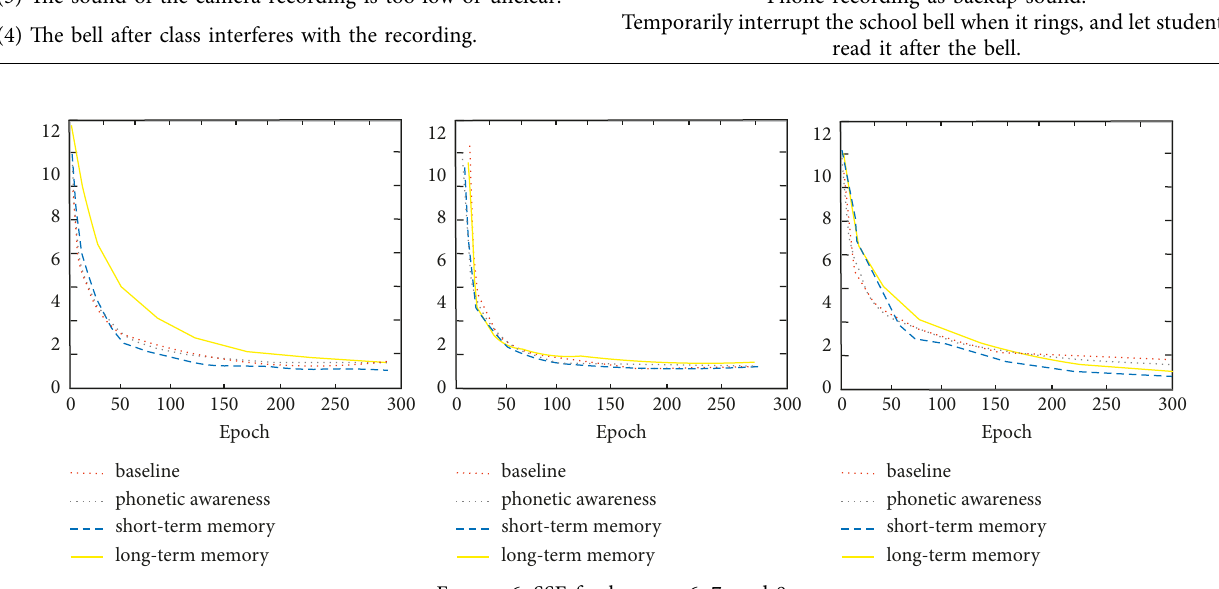
Figure 6: SSE for learners 6, 7, and 8. Table 4: t -test analysis of words, consonants, vowels, and suffixes on each task for two types of students. Task Phonetic awareness